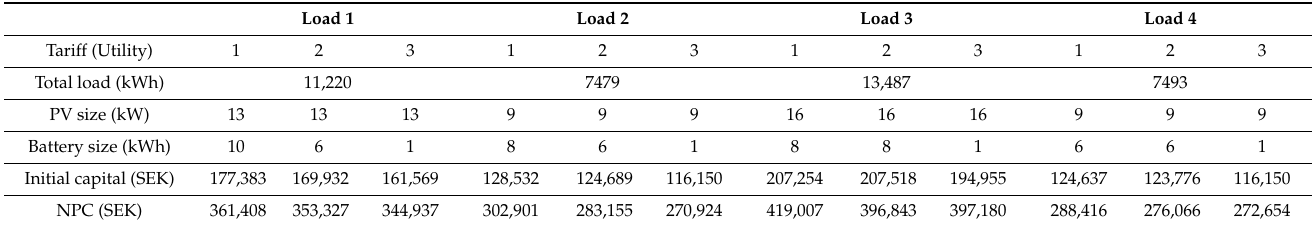
Table 4. Results of pre-sizing grid-connected PV battery systems